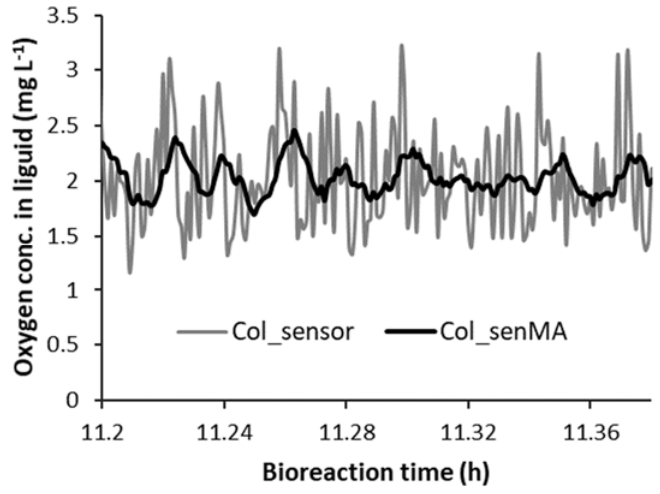
Figure 8. Comparison of the sensor oxygen concentration in liquid ( C OL_sensor ) and its moving average ( C OL_senMA ).